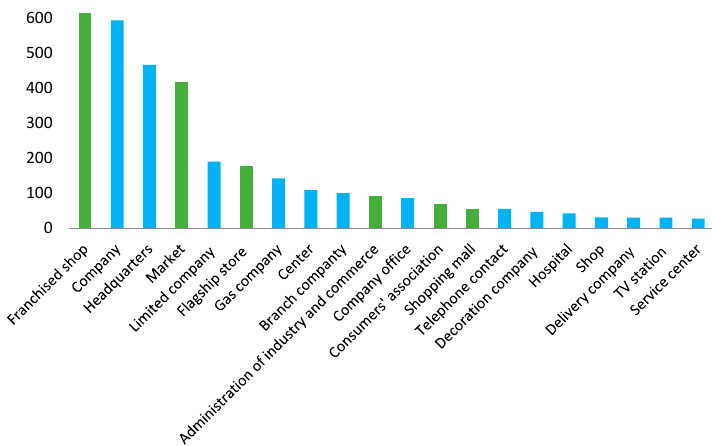
Figure 7. Statistical results of institutional suffix frequency in the natural texts of complaint contents.